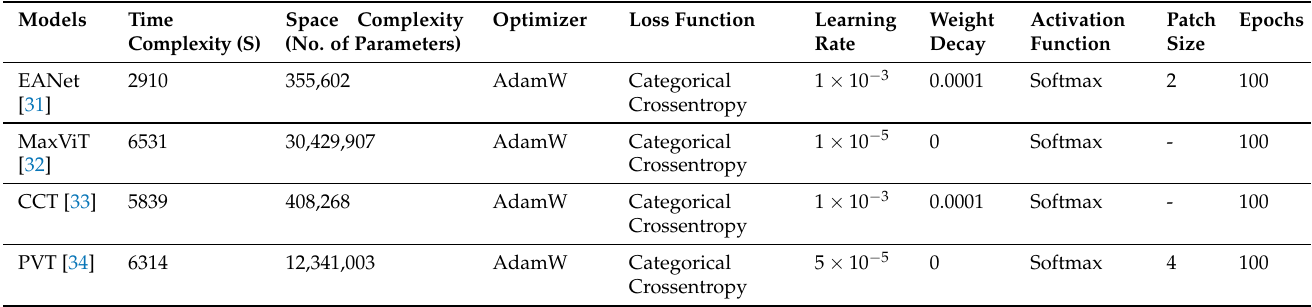
Table 4. Comparison of model